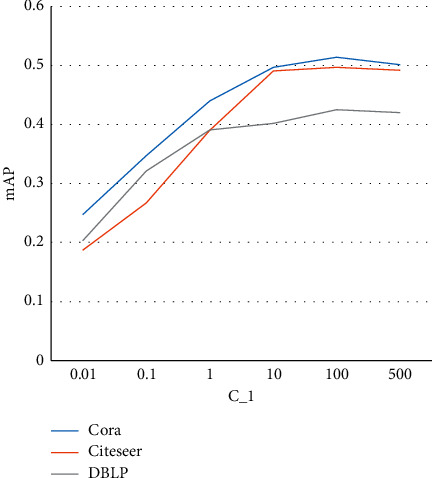
Sensitivity analysis of C1.